Question: Judging by this figure, is the value going up or going down?
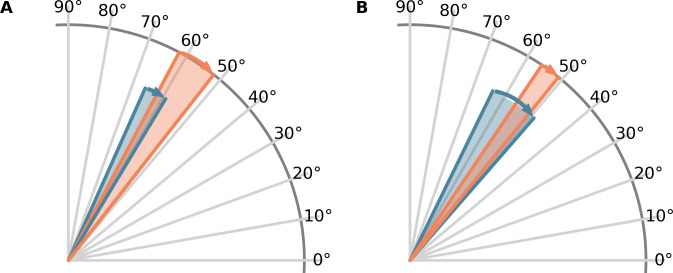
Answer: increasing